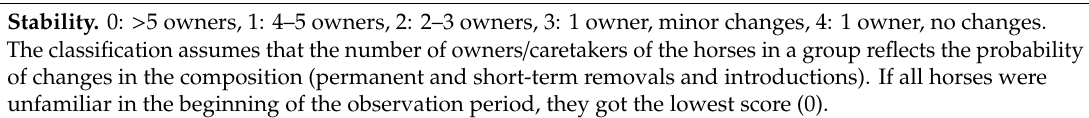
Table 3. Definitions of ranked variables which are used in the analyses.